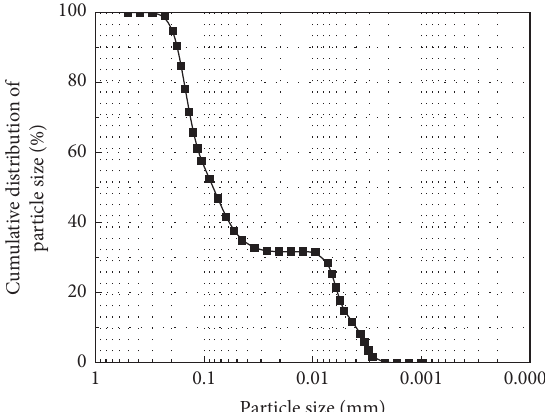
Figure 2: The cumulative size distribution curve of the tailings